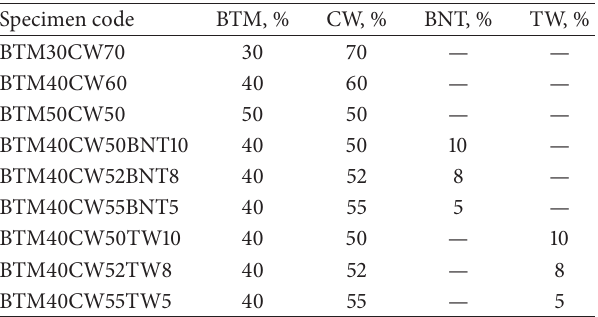
Table 2: BTM/CW, BTM/CW/BNT, and BTM/CW/TW specimens and